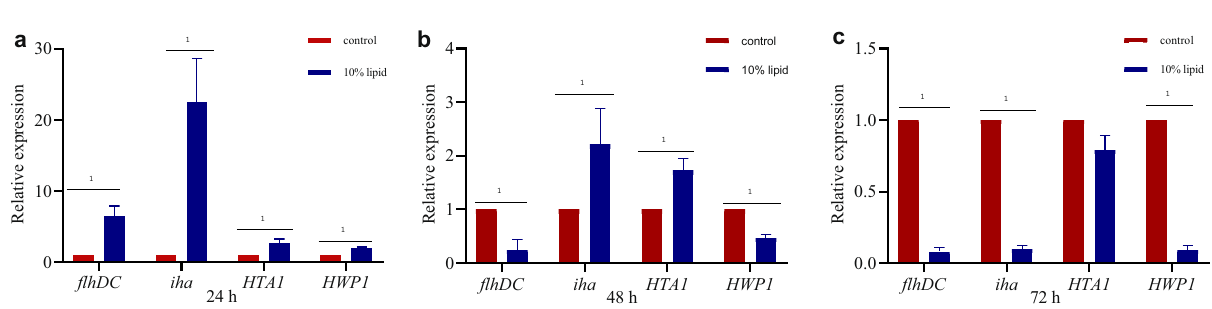
Figure 5. Observation of mixed-species BFs by SEM at 24 h and 72 h. The images were obtained at × 2000 magnification. ( A1 ) Control group (24 h); ( B1 ) 5% lipid emulsion group (24 h); ( C1 ) 10% lipid emulsion group (24 h); ( D1 ) 15% lipid emulsion group (24 h); ( E1 ) 20% lipid emulsion group (24 h); ( A2 ) control group (72 h); ( B2 ) 5% lipid emulsion group (72 h); ( C2 ) 10% lipid emulsion group (72 h); ( D2 ) 15% lipid emulsion group (72 h); ( E2 ) 20% lipid emulsion group (72 h).